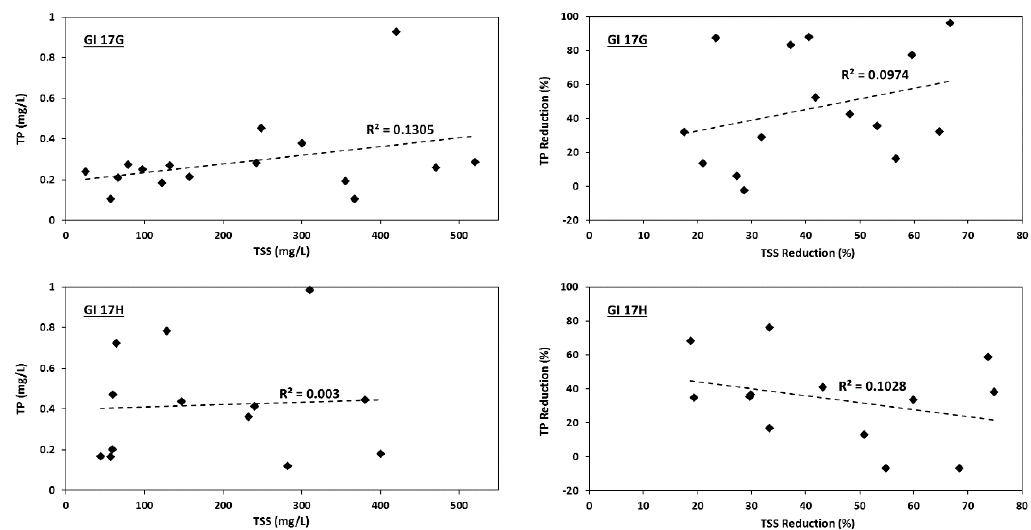
Figure 6. Correlations between total phosphorus (TP) and TSS concentrations, and their reduction